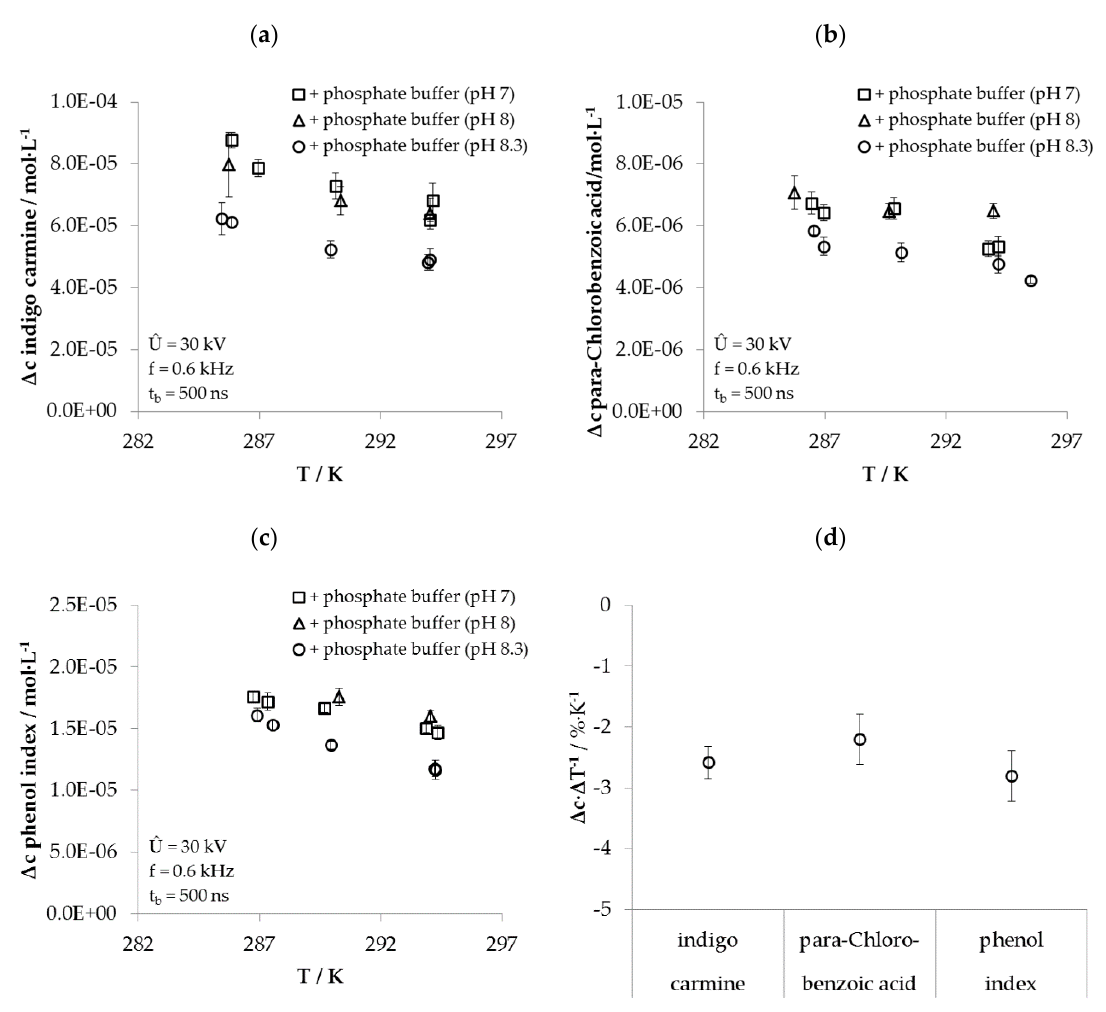
Figure 12. Decrease of ( a ) indigo carmine, ( b ) para-Chlorobenzoic acid, and ( c ) phenol index concentration ( Δ c ) in phosphate buffer matrix at pH 7, 8, and 8.3 depending on process water temperature T and ( d ) percentage temperature-dependent gradients of the decrease in concentration of the reference substances Δ c ∙ Δ T − 1 .